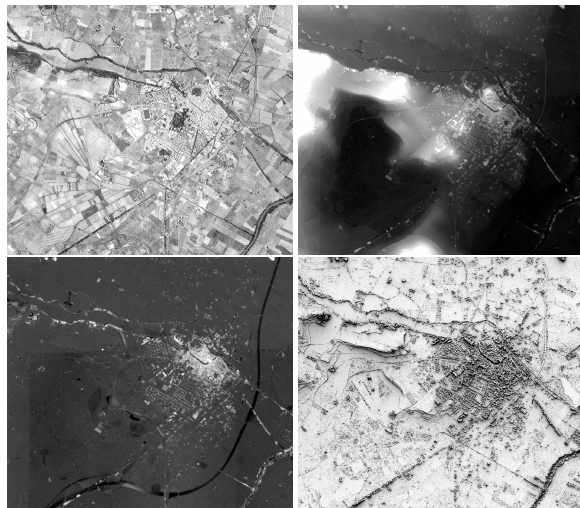
Figure 3. 1981 epoch : ortho-image and different height information representations (raw DSM, normalized DSM and shading map).